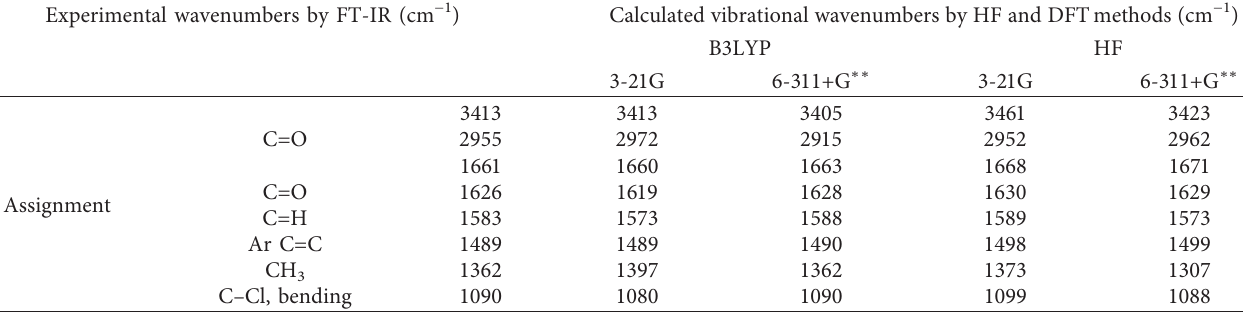
Table 3: The selected experimental and theoretical frequencies of the title compounds using the B3LYP and HF methods for compound (5b) .